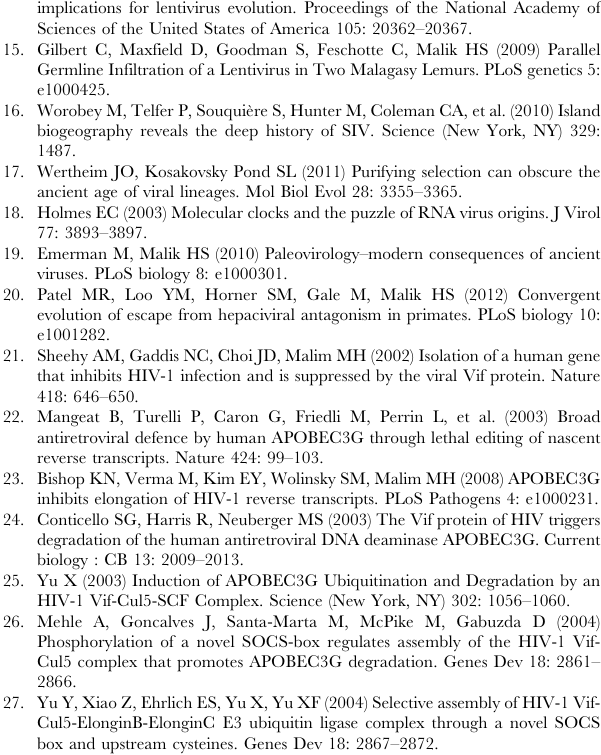
Table S2 Sites undergoing diversifying selection in OWM A3G . The web-based version of HyPhy